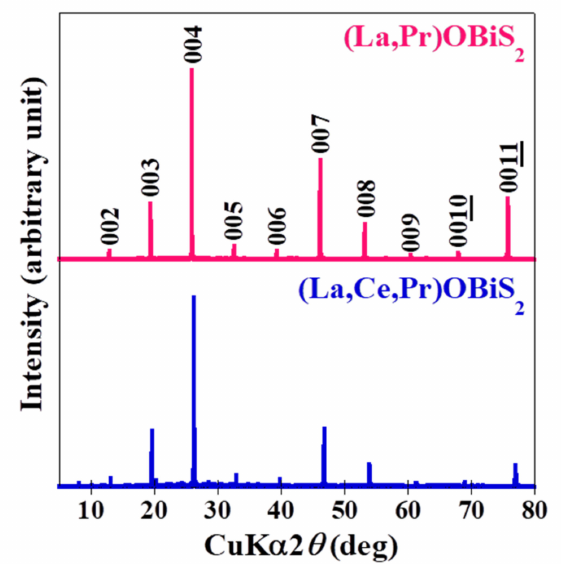
Figure 2. Typical XRD pattern of a well-developed plane of (La,CePr)OBiS 2 and (La,Pr)OBiS 2 single